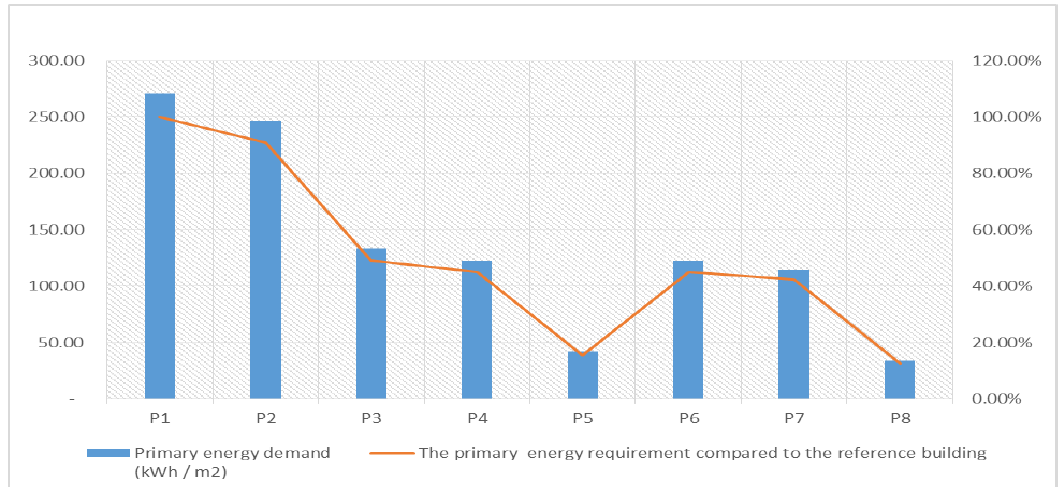
Figure 3. The energy requirement for the reference building as a result of implementing each type of project (in kWh/m 2 ).